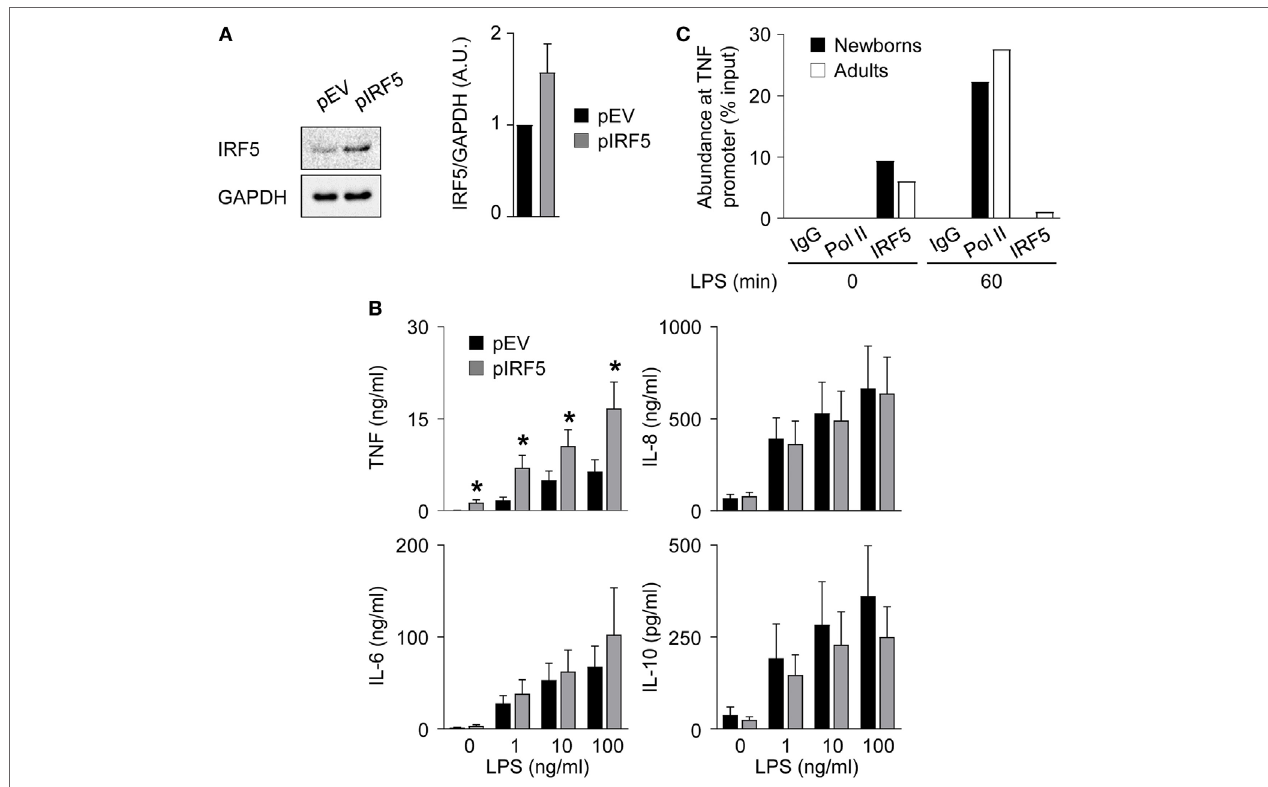
FigUre 6 | IRF5 overexpression restores TNF secretion by newborn M1 macrophages. Newborn M1 macrophages were transduced with empty control (pEV) (black bars) and IRF5-expressing (gray bars) adenoviral vectors (a,B) . (a) IRF5 levels were analyzed by Western blotting (left panel) and quantified by imaging (right panel). (B) Newborn M1 macrophages were stimulated with 0–100 ng/ml lipopolysaccharide (LPS). TNF, IL-6, IL-8, and IL-10 concentrations were measured in cell culture supernatants collected after 20 h. Data are means ± SEM from 20 (TNF) or 10 (IL-6, IL-10, and IL-8) newborns. * P < 0.05. (c) The recruitment of